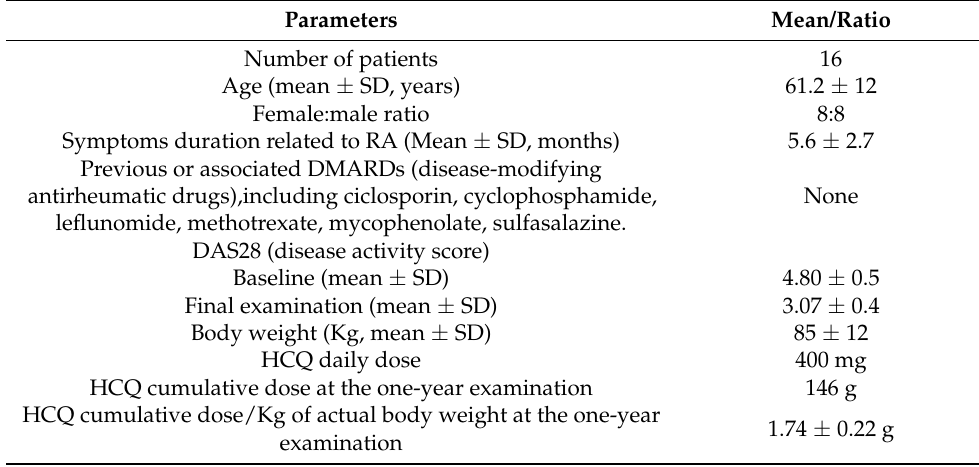
Table 1. Demographic and clinical parameters of rheumatoid arthritis (RA)